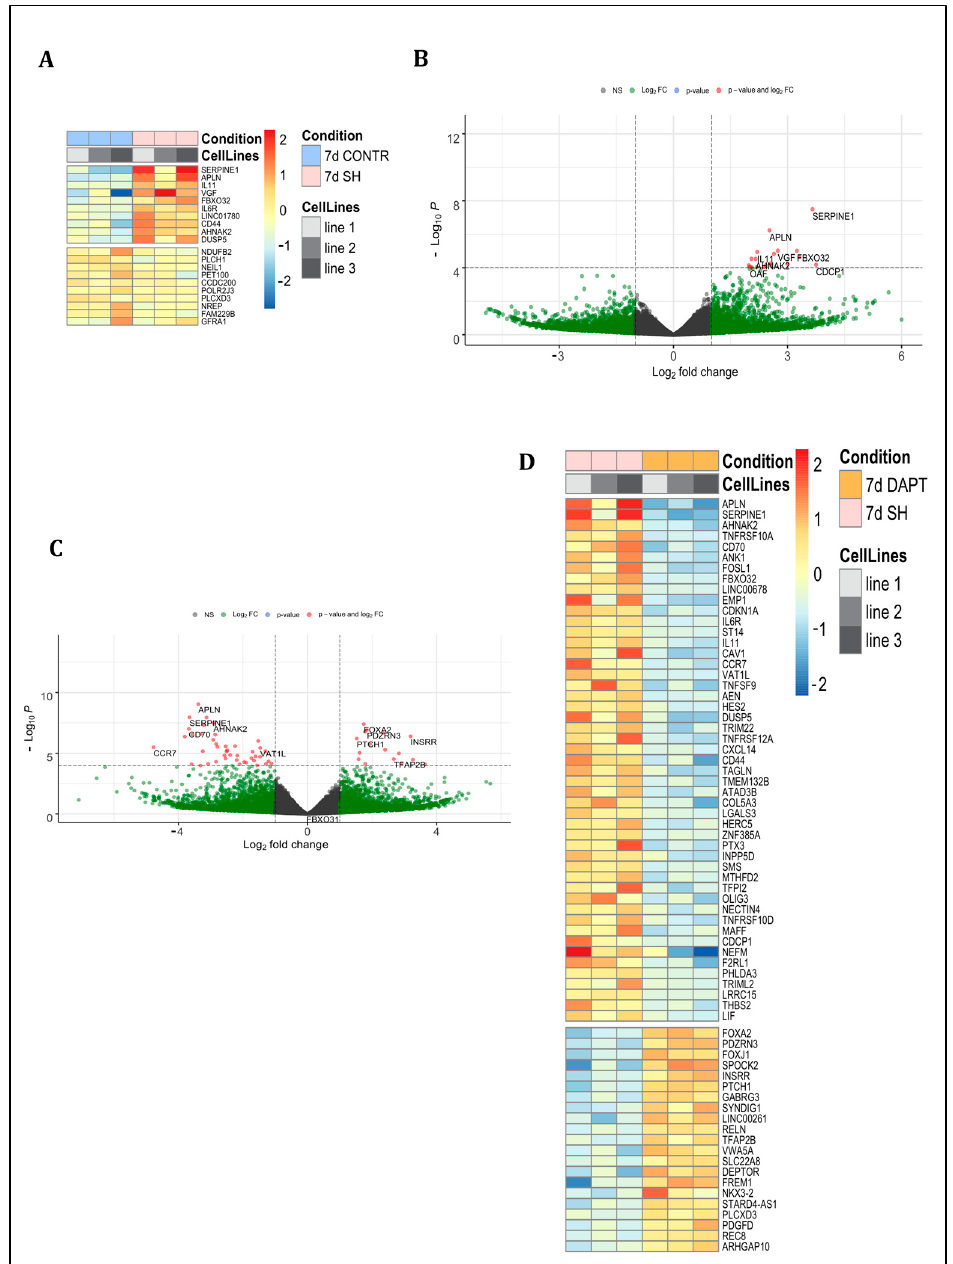
Figure 4. Pairwise comparison of RNA sequencing data of non ‐ treated cells (CONTR) to cells with RBPJ knockdown (SH), and SH cells to cells treated with DAPT (DAPT). ( A ) A heat map of differentially expressed genes between CONTR and SH conditions showed a low number of genes with different expression, top 20 genes. ( B ) Volcano plot of differentially expressed genes between CONTR and SH conditions showed only a few genes with increased expression in the SH group. ( C ) Volcano plot of differentially expressed genes between SH and DAPT conditions showed increased expression of PTCH1, FOXA2, DEPTOR genes in the DAPT condition. ( D ) The heat map of differentially expressed genes between groups SH and DAPT conditions, top 50 genes.